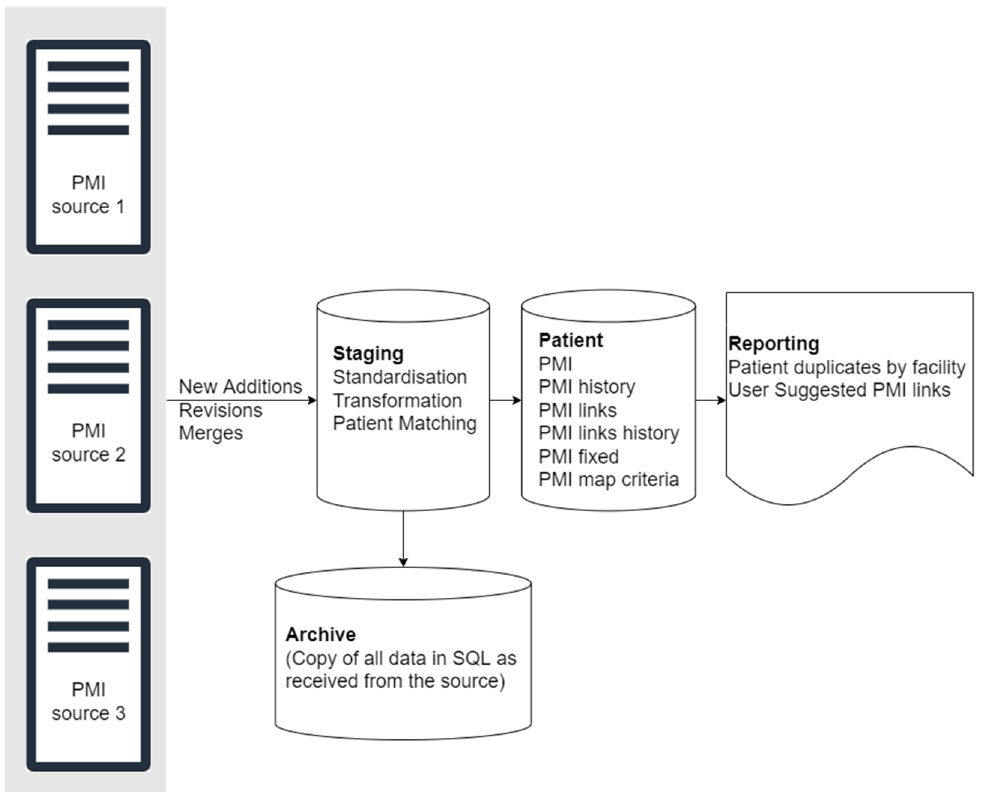
Figure 1: PMI architecture at the